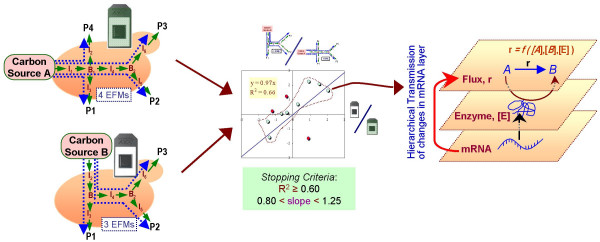
Methodology employed to analyze metabolic flux regulation in response to a shift in carbon source. The change in control-effective fluxes calculated based on determined elementary flux modes (EFMs) is plotted against the change in mRNA levels of the corresponding genes encoding the enzymes catalyzing the reactions. Data points not obeying the correlation are identified by a genetic algorithm approach. Remaining points correspond to hierarchically regulated fluxes.